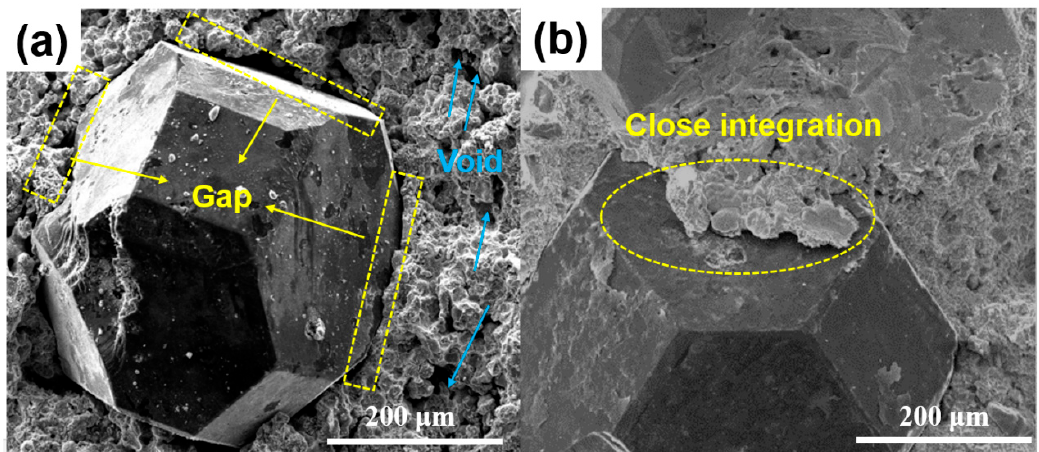
Figure 8. SEM pictures of microstructure morphology of samples sintered by ( a ) CPS (900 °C, 395 MPa, 30 min), ( b ) MPS (900 °C, 395 MPa, 30 min).